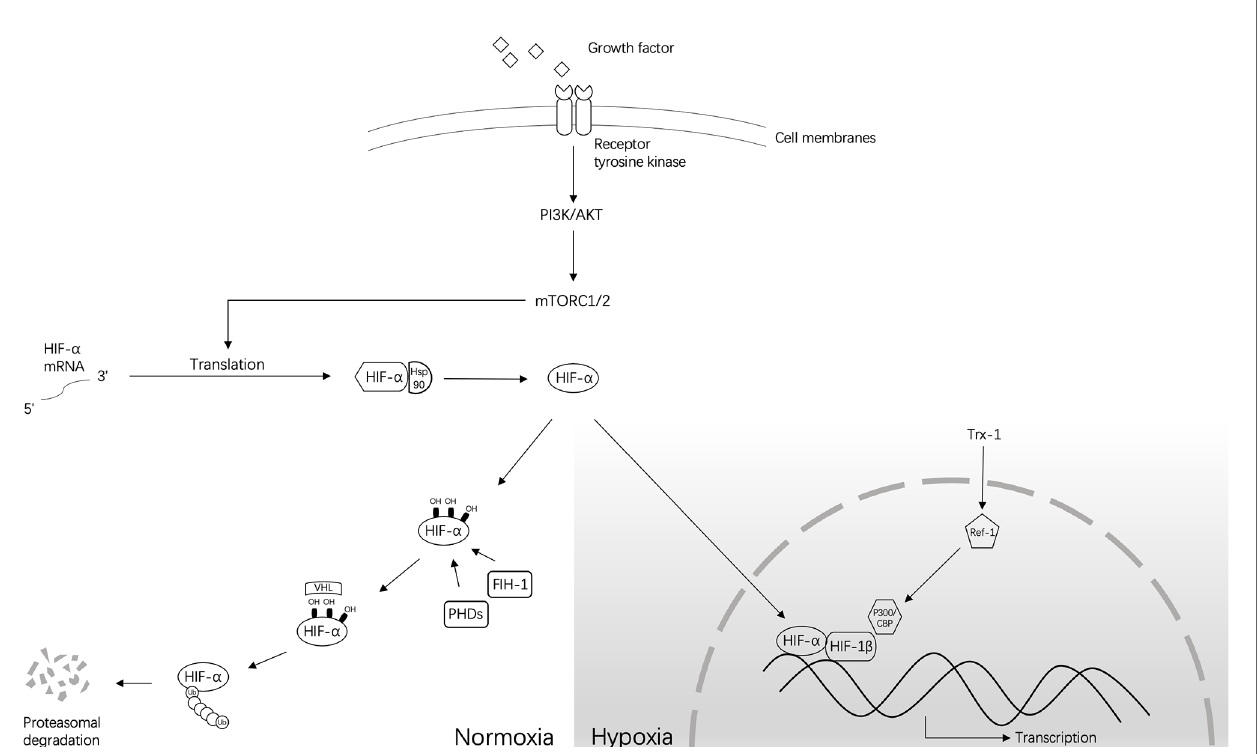
FIGURE 1 | The approximate regulation of HIF-1 under normoxia and hypoxia. Normally, under normoxic conditions, HIF- a hydroxylation is mediated by prolyl 4- hydroxylase (PHD) and factors that inhibit HIF-1 (FIH-1). This process occurs at conserved residues. Hydroxylation of PHD causes instability of the HIF- a protein, and FIH-1 inhibits transcriptional activity by preventing the interaction of HIF- a and CBP/p300. Then, the ubiquitin-dependent process performed by the VHL complex mediates the subsequent degradation of HIF- a . However, under hypoxic conditions, PHD and FIH-1 are inactivated, leading to the stabilization of HIF- a and its translocation into the nucleus to dimerize with HIF-1 b /ARNT and form HIF transcription factors. Without the involvement of FIH-1, HIF will transcribe a large number of target genes together with CBP/p300. Other small molecules that can regulate this process are also shown in this fi